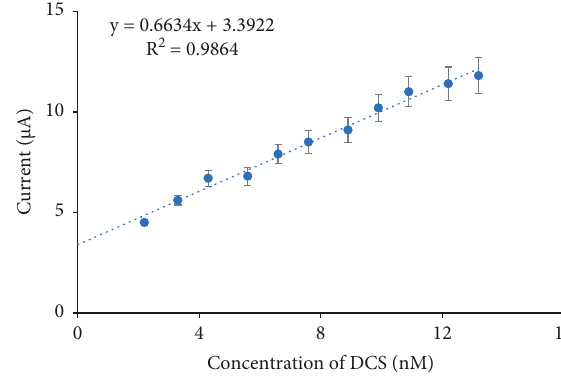
Figure 6: Calibration plot of Ads-DP-ASVs of DCs at different concentrations (2.5–13.19nM) at GCE vs. Ag/AgCl electrode. Sweep rate 100mVs − 1 , 5s accumulation time, 70mV pulse am- (cid:29) plitude and 0.07 V deposition potential at pH